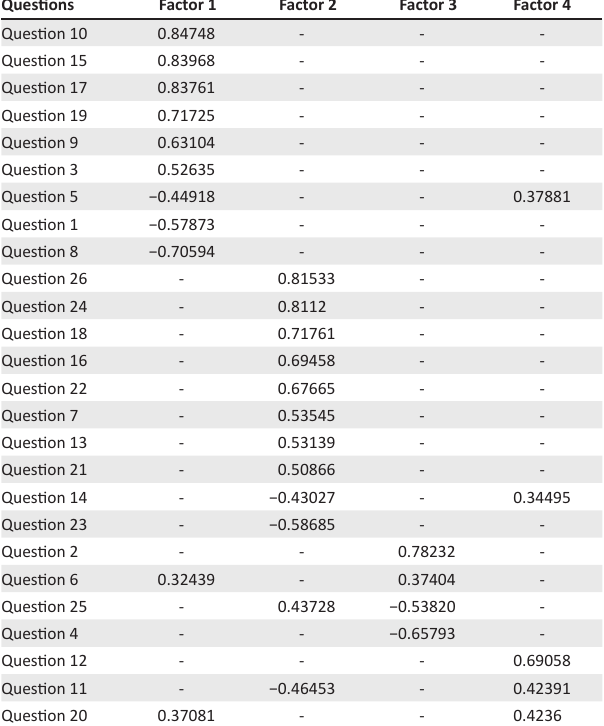
TABLE 1: Factor loadings.